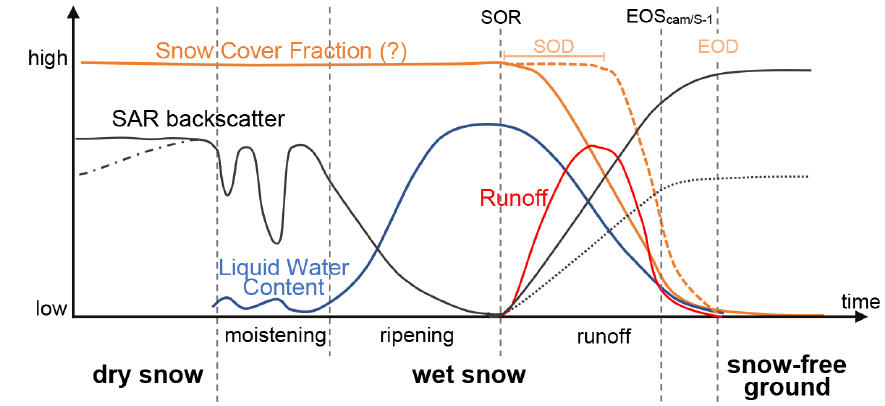
Figure 1. Schematic illustration of the pixel-wise seasonal evolution of synthetic aperture radar (SAR) backscatter intensity above snow with its phases of melt and relevant snow properties, i.e., liquid water content, runoff and snow cover fraction. This illustration (modified from Tsai et al., 2020) is based on the findings of Marin et al. (2020) and Tsai et al. (2020) and shows the parameters used in this study: SOR – start of runoff; SOD – start of snow cover fraction decrease which varies in time (indicated by the range of SOD and the different snow cover fraction curves) depending on snow pack properties and melt rates; EOS cam / S-1 – end of snow cover detected by camera/Sentinel-1; EOD – end of snow cover fraction decrease. The understudied interaction between Sentinel-1 SAR backscatter and snow cover fraction during the runoff phase and the potential of SAR time series to detect snow cover depletion during melt are investigated by this